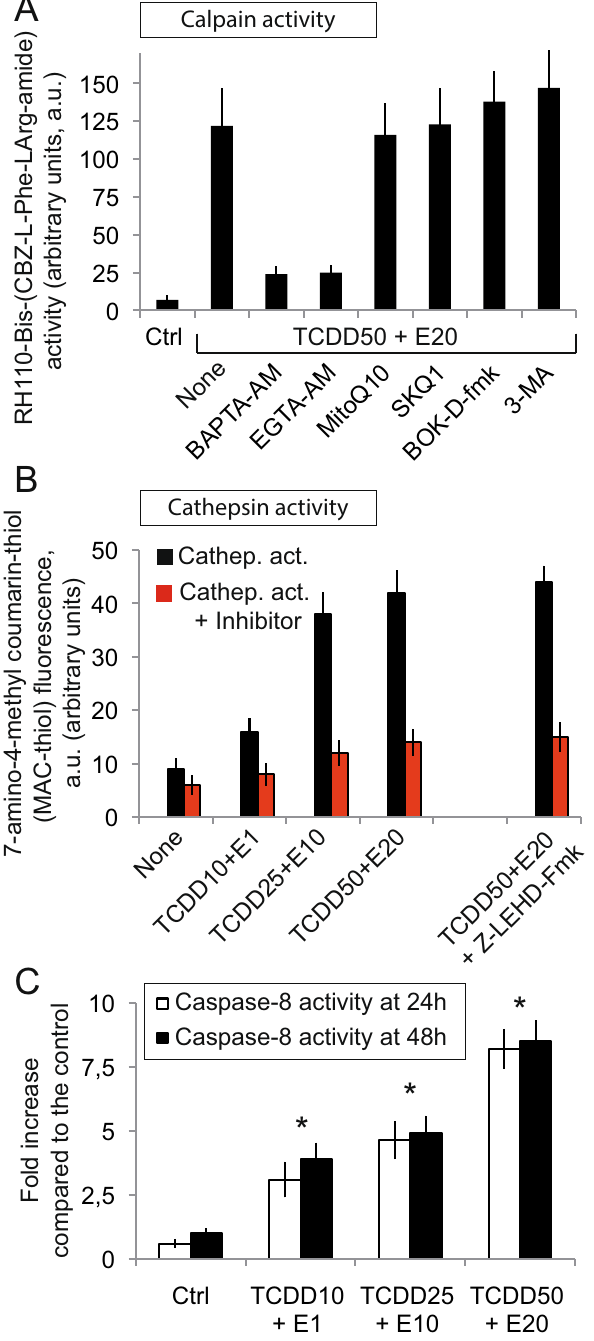
Figure 9. Cathepsin, calpain and caspase-8 activation by α -E, TCDD or pollutant cocktails. ( A ) Flow cytometry analysis of Caco-2 cells calpain activity following the incubation of cells with a pollutant cocktail (TCDD 50 nM + α -E 20 μ M) for 24 h in the presence of calcium chelators, BAPTA-AM or EGTA-AM, mitochondrially targeted antioxidants (MitoQ10 or SKQ1), a pan caspase inhibitor BOK-D-fmk or 3 methyladenine an inhibitor of autophagy (n = 8). ( B ) Cathepsin activity in Caco-2 cells treated with a cocktail of pollutants for 48 h. A cathepsin inhibitor cocktail has been tested as well for the effects of z-LEHD, an inhibitor of caspase-9 (n = 6). ( C ) Caspase-8 activity in Caco-2 cells treated with TCDD 50 nM + α -E 20 μ M has been tested at 24 h and 48 h (n =